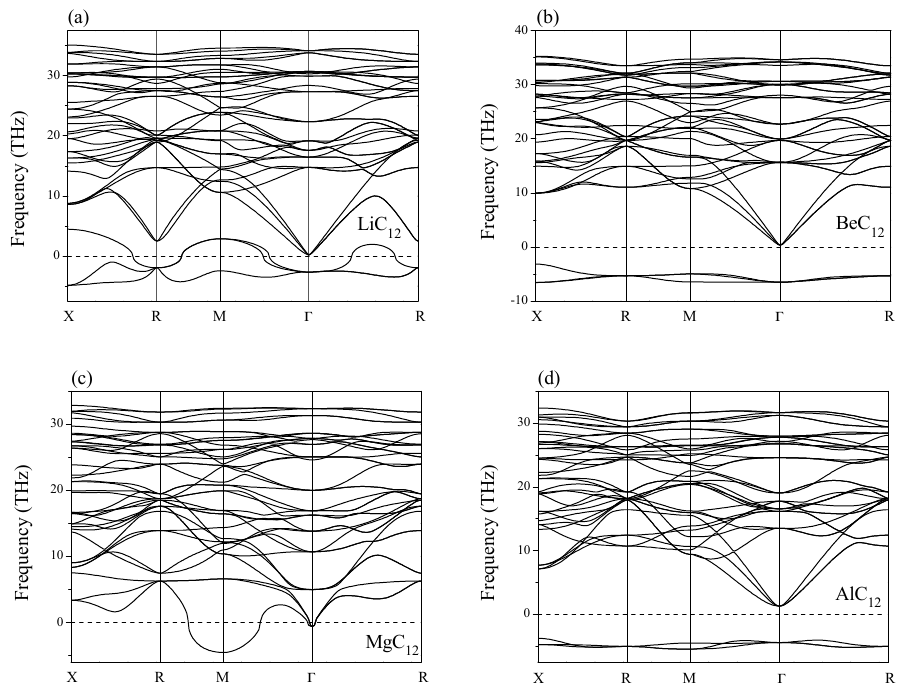
Figure 4. Phonon spectra of dynamically unstable phases ( a ) LiC 12 ; ( b ) BeC 12 ; ( c ) MgC 12 ; and ( d ) AlC 12 .